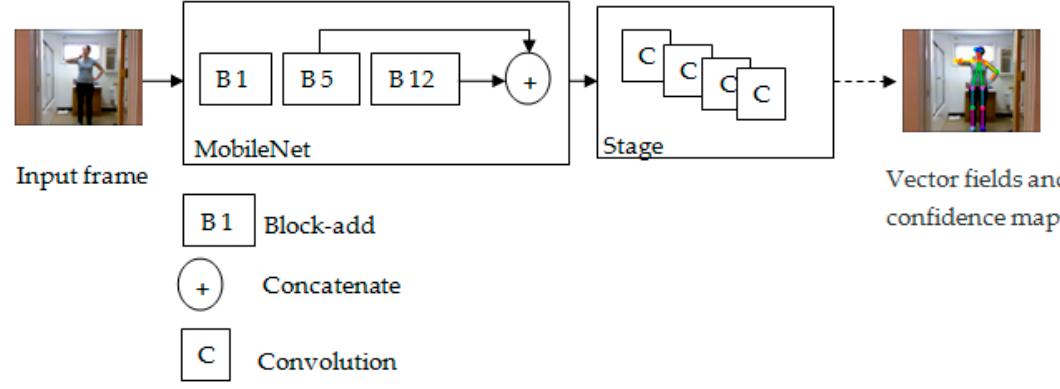
Figure 2. The MobileNet architecture for skeleton joint representation. The selected human features are presented in a CSV file containing 36 values from 18 joints. The feature vectors computed are concatenated to build features of a dataset matrix associated with human activities in a video. Human activity features are presented as matrices with 37 columns by N rows; the columns present 36 values of skeleton joints and classification of the skeleton presentation. The rows correspond to features from di ff erent frames of human activities in the Cornell Activity Dataset (CAD )60